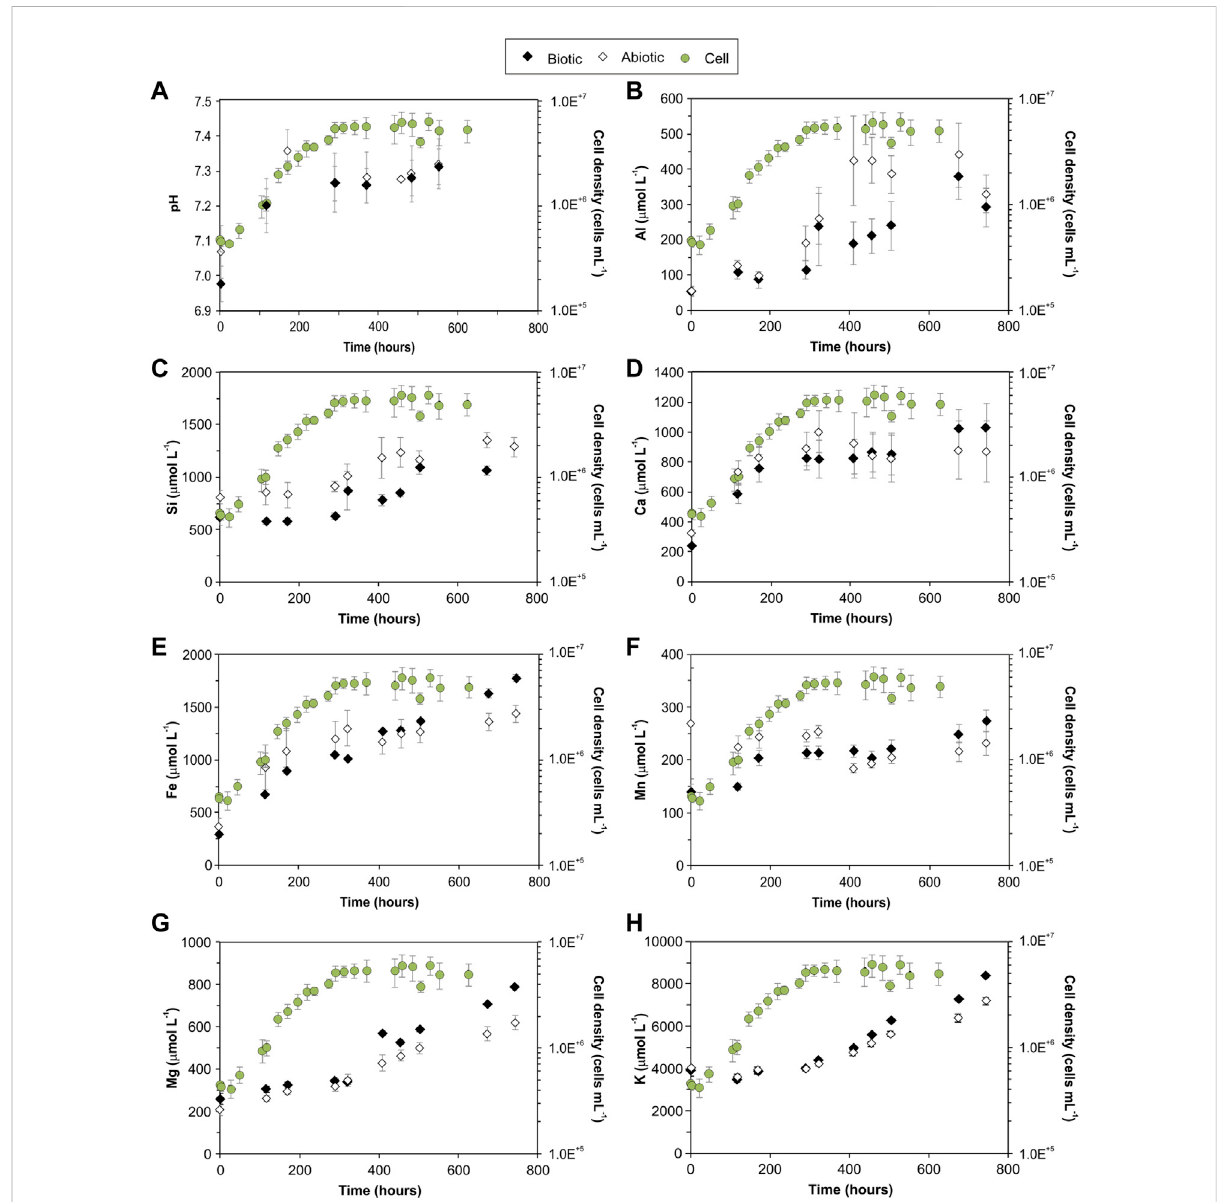
FIGURE 1 MeanpHvalueofthemedium (A) andmeanconcentrationofelementsinthemedium (B – H) overthecourseofbioticandabioticexperiments, plotted in parallel to the logarithmic plot of cell density. Error bars represent the standard error of the mean for all series. Full data are listed in Supplementary